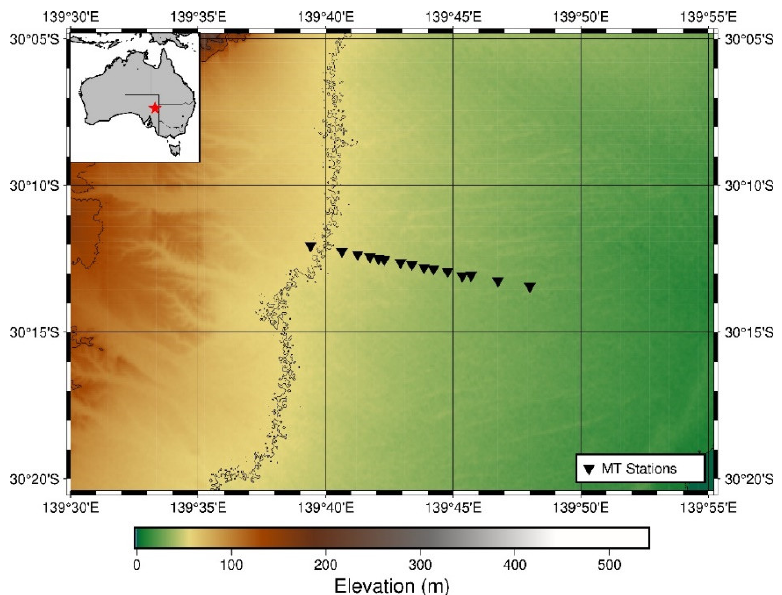
Figure 16. Field map of the MT survey line in South Australia, Australia. The black triangles represent the MT stations collecting the surface measurements. The box on the top-left and the red star denote the worldwide location of the MT exploration project.